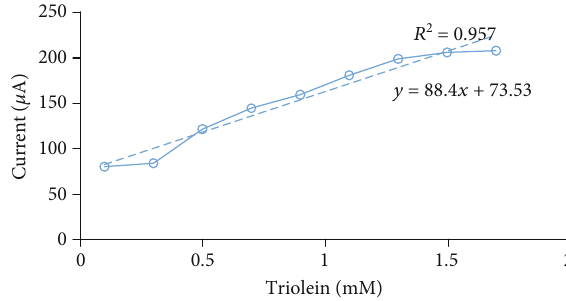
Figure 6: The calibration curve for the developed